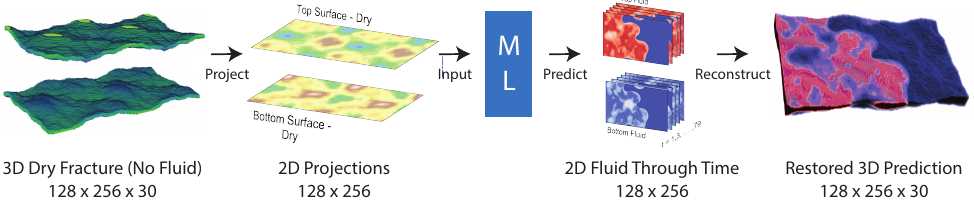
Figure 4. Proposed workflow. The 3D fracture geometry is compressed into two 2D projections (as described in Section 2.2). The 2D predictions from the model are then used to reconstruct a simulation for the original fracture